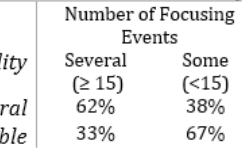
Table 4: Number of Focusing Events by Perceived Credibility of FEMA